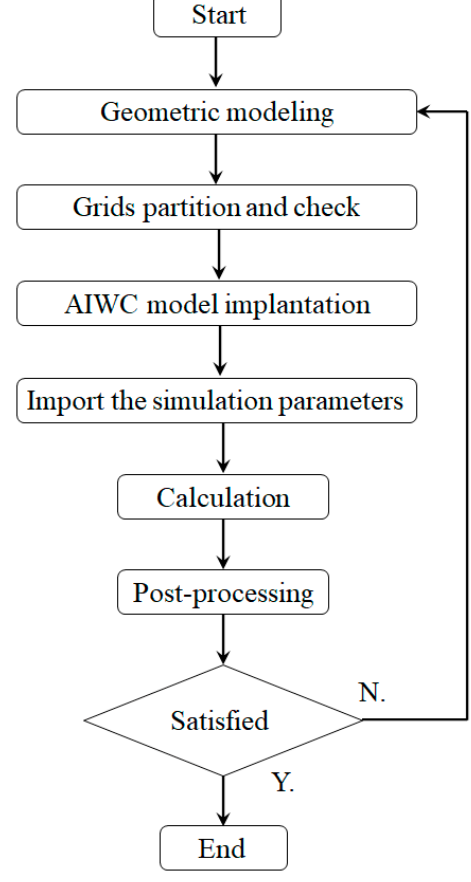
Figure 2. Schematic diagram of the simulation. Table 3. Detailed model parameters and operating conditions.